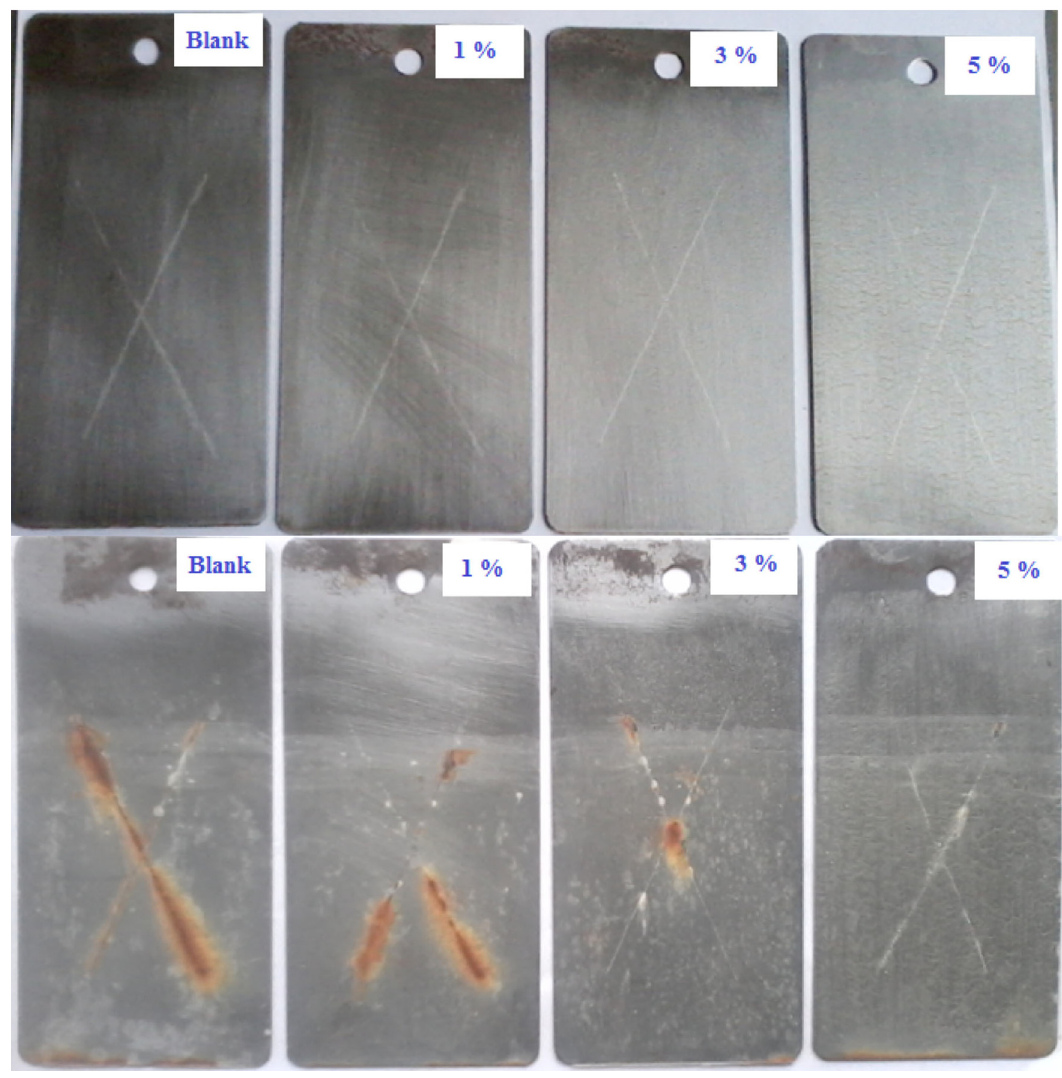
Figure 16: Corrosion test results of steel panels coated with PU coatings with di ff erent percentages of polyurea microcapsules containing tung oil before and after testing for 120 h [ 36 ]